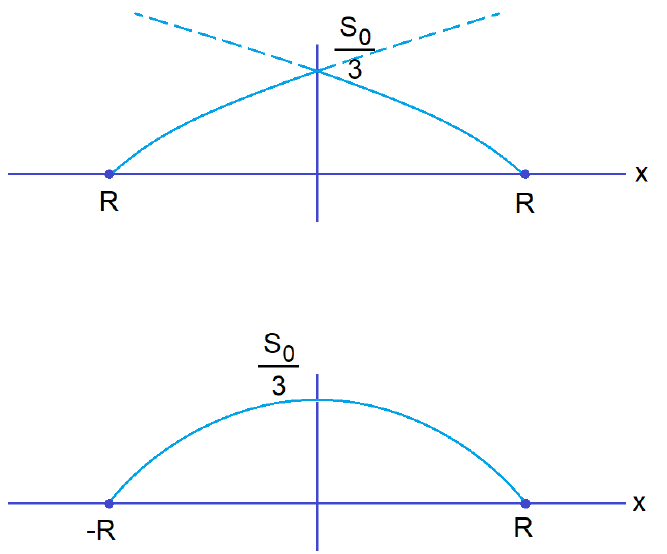
Figure 12. Entropy deficit and a function of x . The upper panel incorrectly shows a cusp at the Nariai point. The lower panel shows the correct smooth behavior